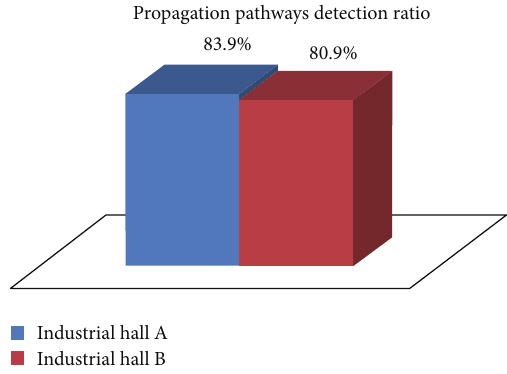
Figure14:Percentageofsuccessfullydetectedfavorablepropagation